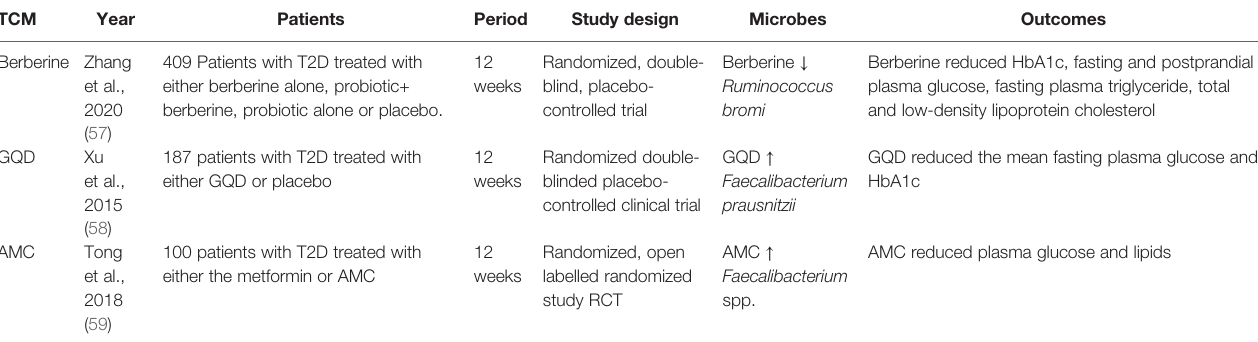
TABLE 2 | Summary of the effects of traditional Chinese medicine on the composition of the gut microbiome in T2D